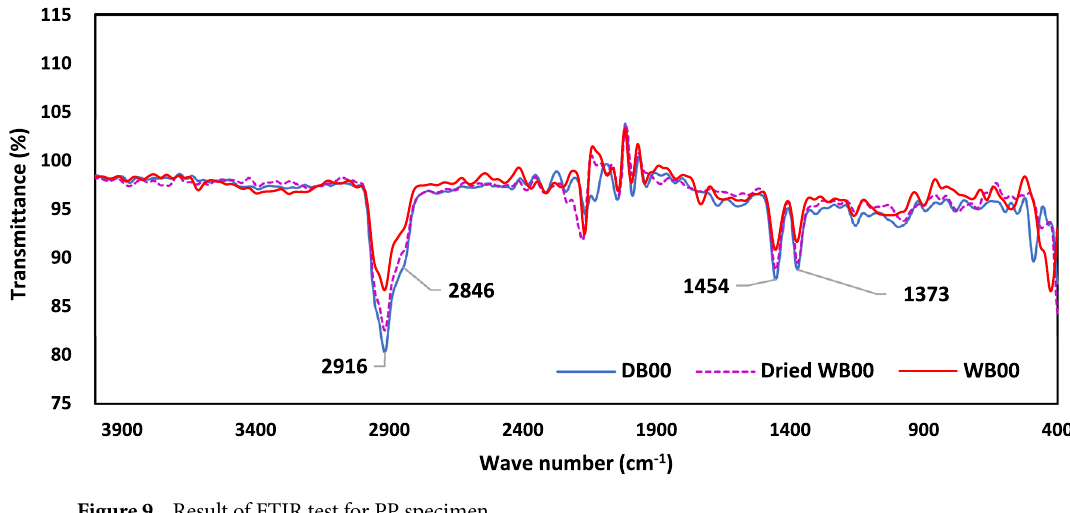
Figure 9. Result of FTIR test for PP